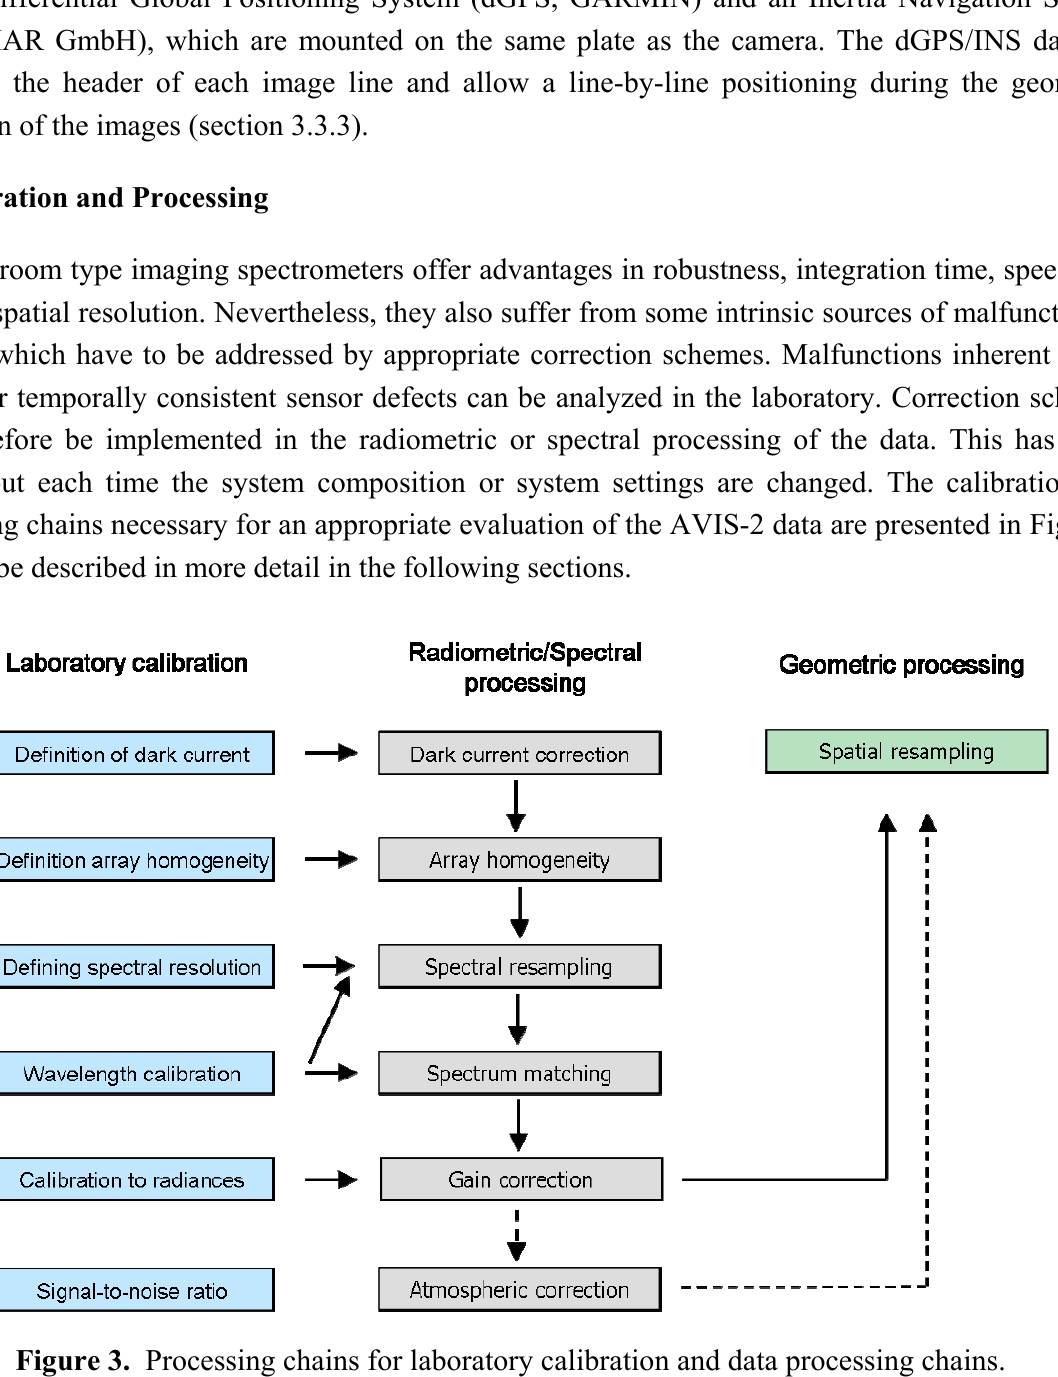
Figure 3. Processing chains for laboratory calibration and data processing